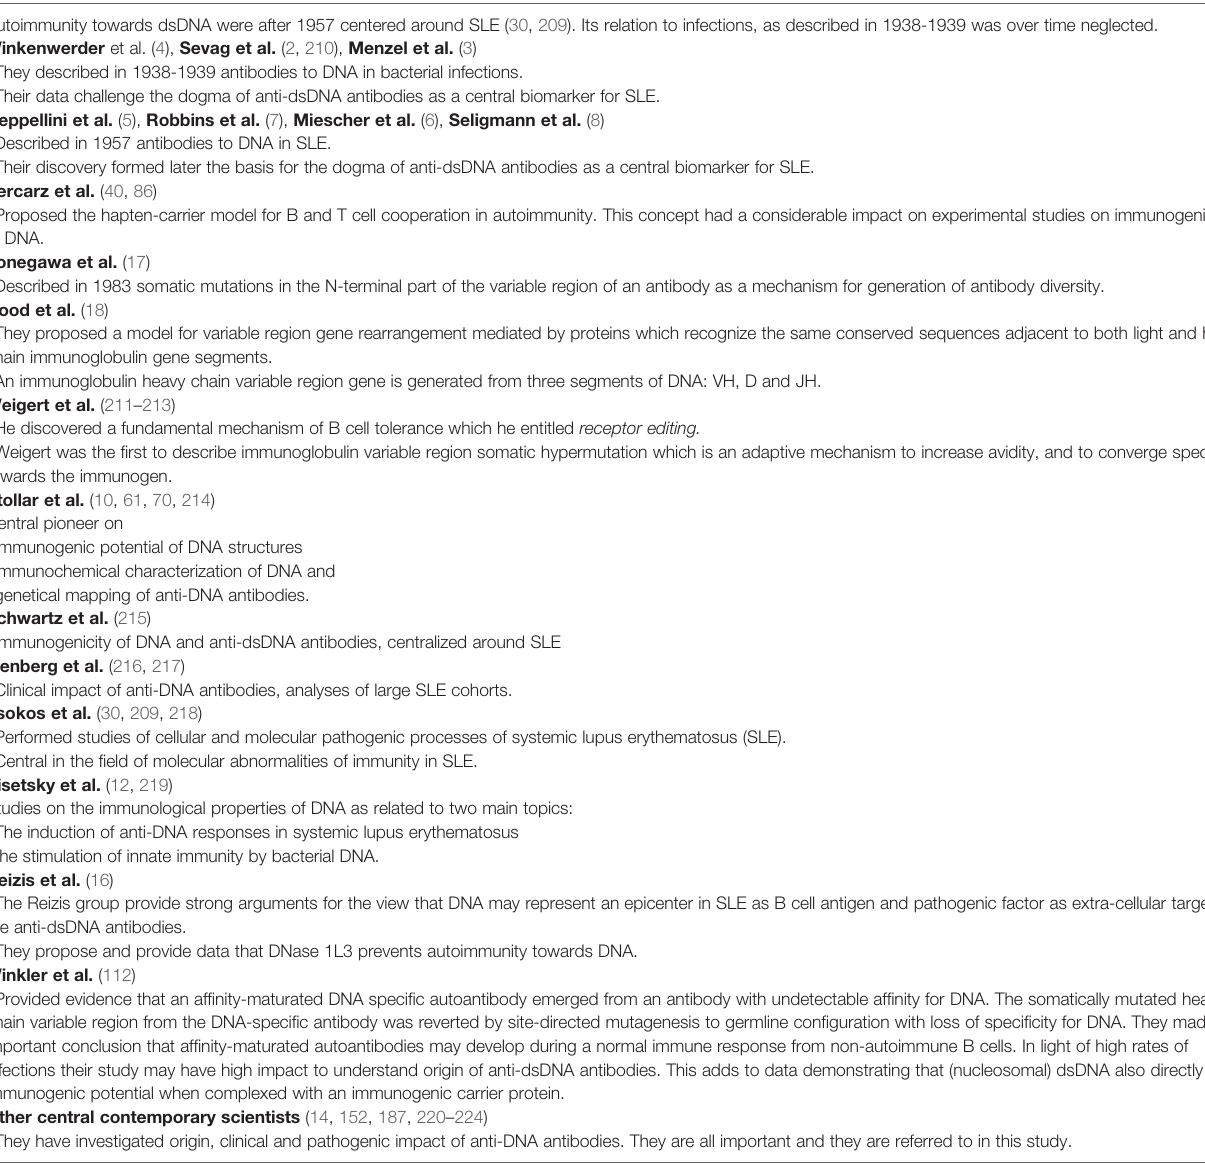
TABLE 3 | Central scientists and milestone studies of anti-dsDNA antibodies. Autoimmunity towards dsDNA were after 1957 centered around SLE (30, 209). Its relation to infections, as described in 1938-1939 was over time neglected. Winkenwerder et al. (4), Sevag et al. (2, 210), Menzel et al.